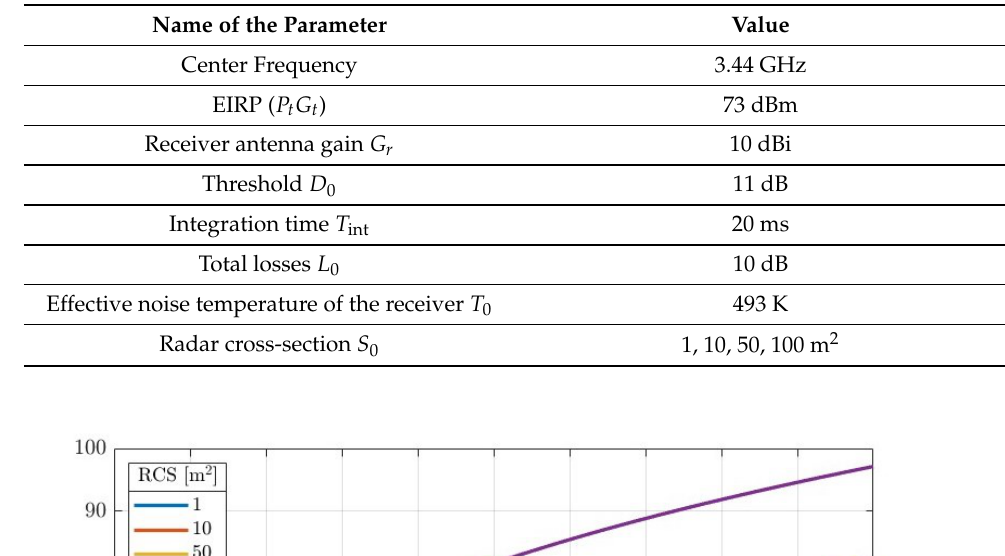
Table 2. Simulated network parameters.